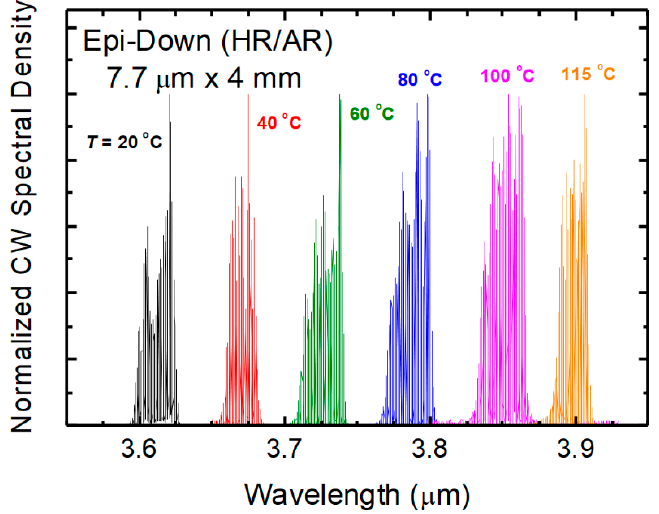
Figure 8. Cw emission spectra for a 7.7- μ m-wide 4-mm-long narrow-ridge 5-stage ICL mounted epi-side-down, with an HR-coated back facet and an AR-coated front facet, at temperatures between 20 °C and 115 °C. Adapted from Ref. [94].